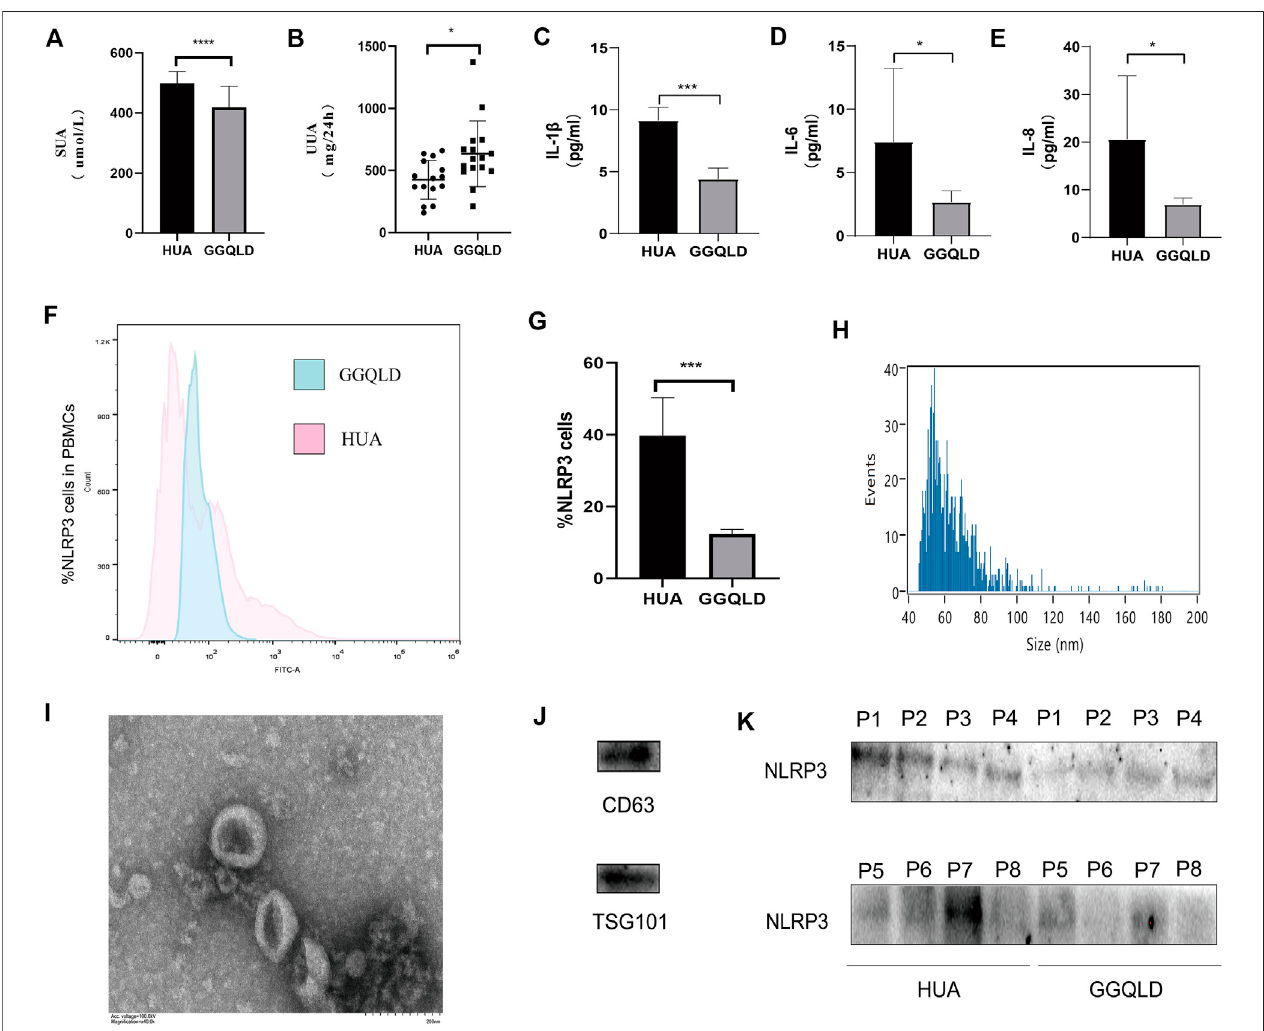
FIGURE 4 | NLRP3 expression is suppressed in HUA patients after GGQLD treatment. (A – E) Serum uric acid, 24 h urine uric acid, IL-1 β , IL-6, and IL-8 were studied beforeandaftermedication. (F) PBMCs,freshlyisolatedbyFicoll – Paquedensitygradientcentrifugation,werestainedwithmAbsconjugatedwithFITCanddata acquiredby fl owcytometry.CellsweregatedasshowninFigure. (G) TheexpressionofNLRP3in fl ammatoryproteininPBMCsofHUApatientswassigni fi cantlyreduced after GGQLD treatment. (H – J) Exosome nanoparticle tracking analysis; Exosomes under electron microscope; the characterization exosomes with related markers. (K) The expression of NLRP3 in fl ammatory protein in urinary exosomes of HUA patients was signi fi cantly reduced after GGQLD treatment. For (K) , n (cid:2) 3 independent experiments per group. In all statistical plots, data are expressed as the mean ± SD, * p < 0.05, ** p < 0.01, *** p < 0.001, **** p < 0.0001.